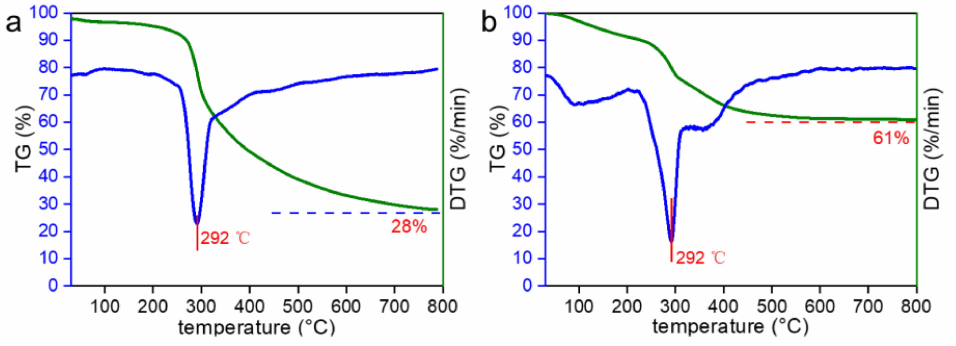
Figure 8. TGA and DTG curves of ( a ) PAP-1 and ( b )